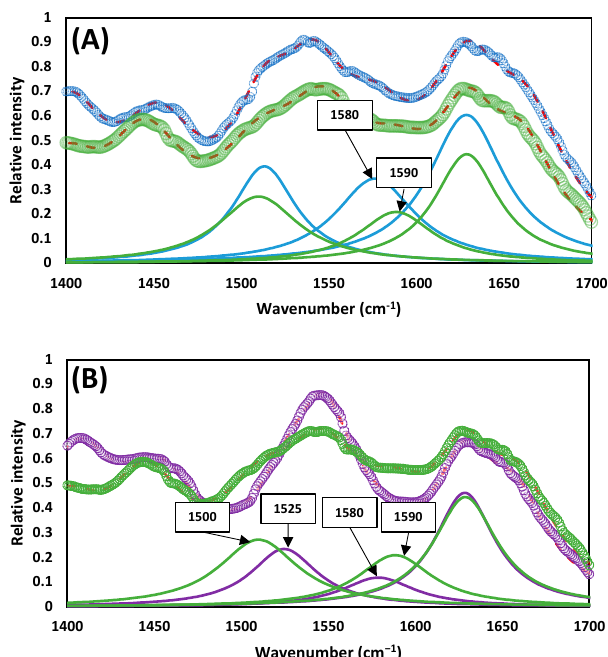
Figure 4. FTIR of the sludge before (green lines) and after (blue lines) thermal treatment, during TH-AD process, between ( A ) the range of 4000 cm − 1 and 2000 cm − 1 and ( B ) between the range of 2000 cm − 1 and 600 cm − 1 . The deconvoluted spectrum with the fitted component band is also shown for ( C ) the untreated sludge and ( D ) the pre-treated sludge, between the range of 2000 cm − 1 and 600 cm − 1 . Orange lines represent the fitted curves associated with recalcitrant compounds (peaks at 1630 cm − 1 , 1580 cm − 1 , and 1510 cm − 1 ) and black lines represent the other fitted curves between the range of 2000 cm − 1 and 600 cm − 1 .